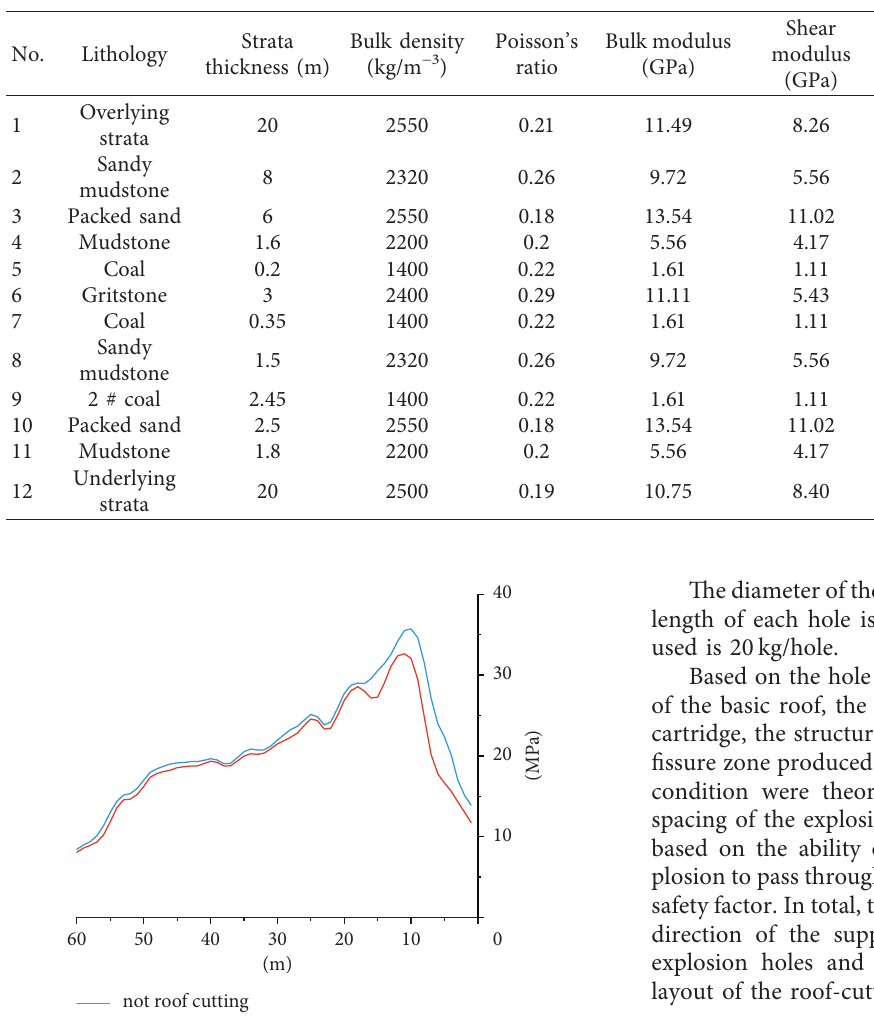
Figure 9: Numerical calculation model. Table 1: Mechanical property parameters of the strata in the model.